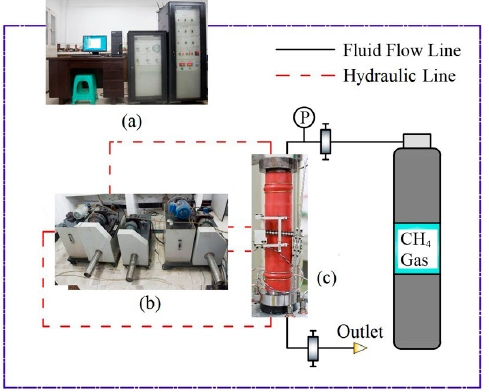
Figure 6. RLW-2000M rock mechanical testing system (Chaoyang Instrument Factory, Changchun, China) and deformeter (Teratech, Burlington, MA, USA).